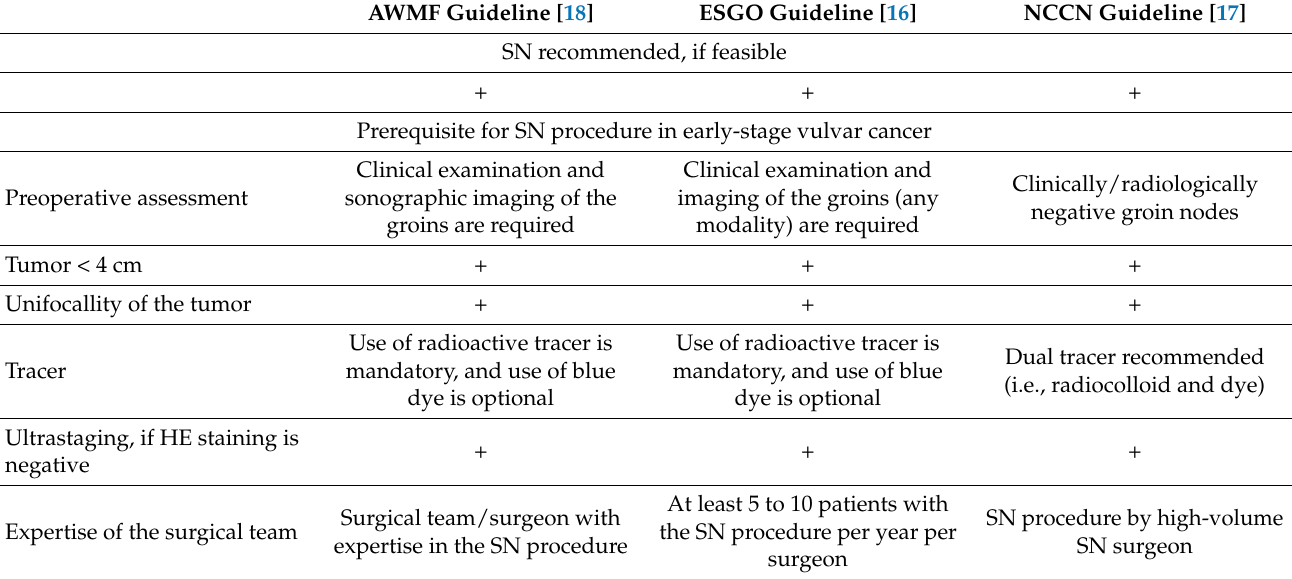
Table 1. Comparison of recommended procedures with regard to sentinel node procedure by differ- ent